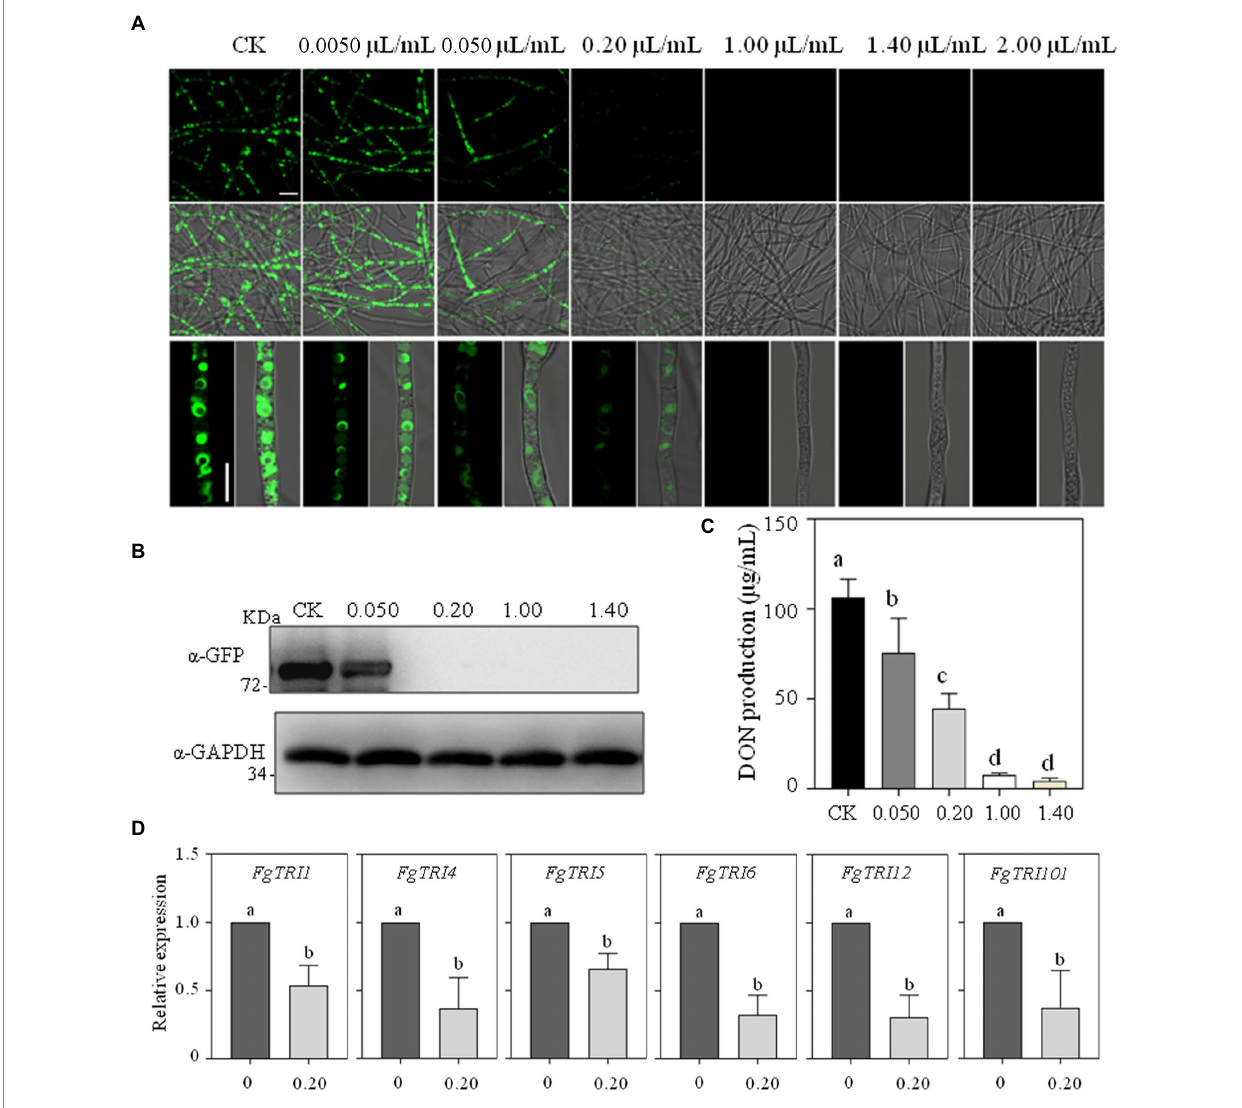
FIGURE 3 Limonene formulation inhibited toxisome formation and DON production in Fusarium graminearum. (A) Limonene formulation with different concentrations impeded toxisome formation. The fluorescence signal of Δ FgTri1::FgTri1GFP strain was examined after limonene formulation treatment. Bars, panel = 10 μ m. (B) FgTri1-GFP protein levels were decreased by limonene formulation. (C) Mycotoxin DON production was inhibited by limonene formulation. Different letters represent statistically significant differences according to the one-way ANOVA test ( p < 0.05). (D) The relative expression levels of DON biosynthetic genes were decreased by the treatment of 0.20 μ l/ml limonene formulation. Different letters represent statistically significant differences according to the one-way ANOVA test ( p <